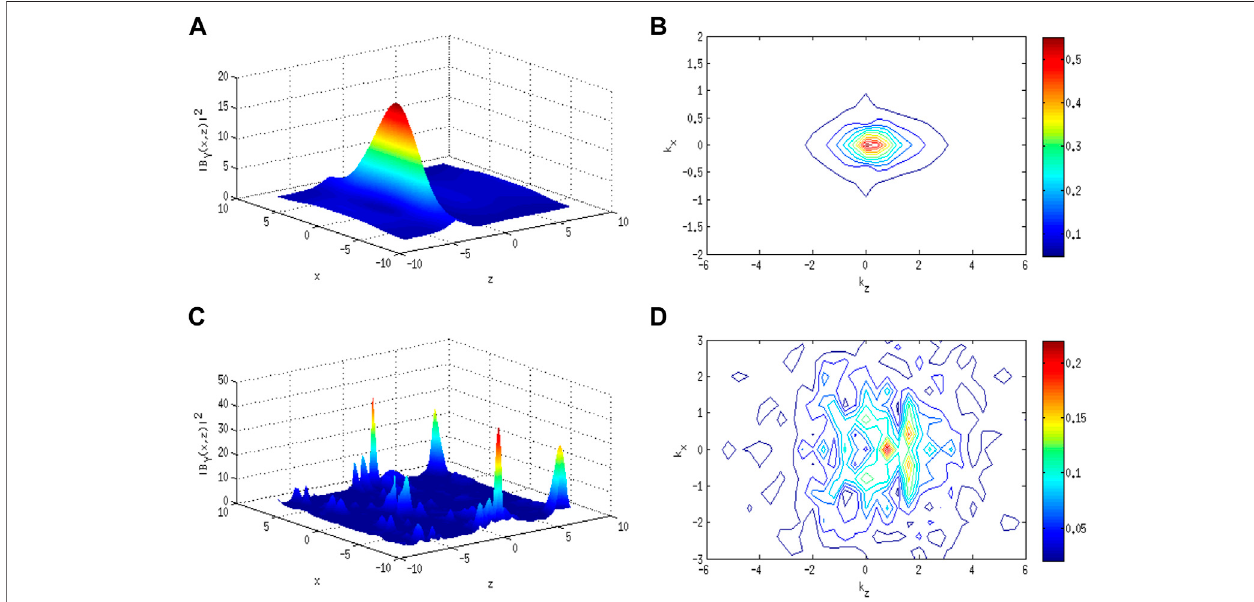
FIGURE 2 | With IC-2. (A) Normalized intensity pro fi le of the KAW magnetic fi eld (| B 2 y | / B 2 n ) at normalized t = 6 (t normalized by t n (cid:2) 2 ω / V 2 A k 2 0 z ) in a normalized x – z plane ( x normalized with x n (cid:2) ρ s and z normalized by z n (cid:2) 2/ k 0 z ). (B) Contours ofnormalized | B yk | 2 against Fouriermodes ofKAWat t=6. (C) Normalized magnetic fi eld intensity pro fi le of KAW at t = 13. (D) Contours of normalized | B yk | 2 against Fourier modes of KAW at t = 13. “ Reproduced from [(Gaur and Sharma, 2014), Astrophys Space Sci (2014) 350 , https://doi.org/10.1007/s10509-013-17701], with the permission of Springer Publishing. ”